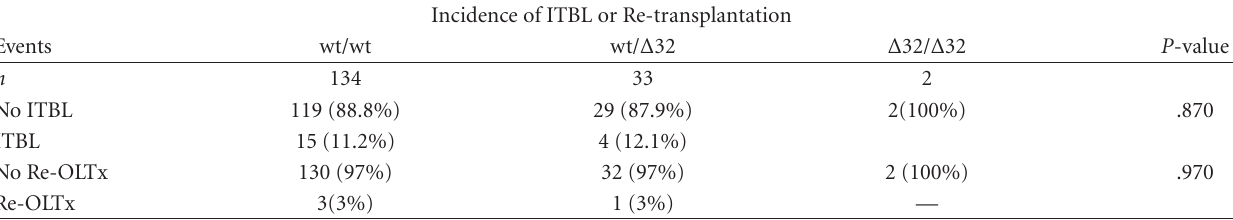
Table 3: Events after transplantation. wt/wt: wild type CCR-5; wt/ Δ 32: heterozygous CCR-5 Δ 32; Δ 32/ Δ 32: homozygous CCR-5 Δ 32; ITBL: ischemic-type biliary lesion; Re-OLT: retransplantation. Incidence of ITBL or